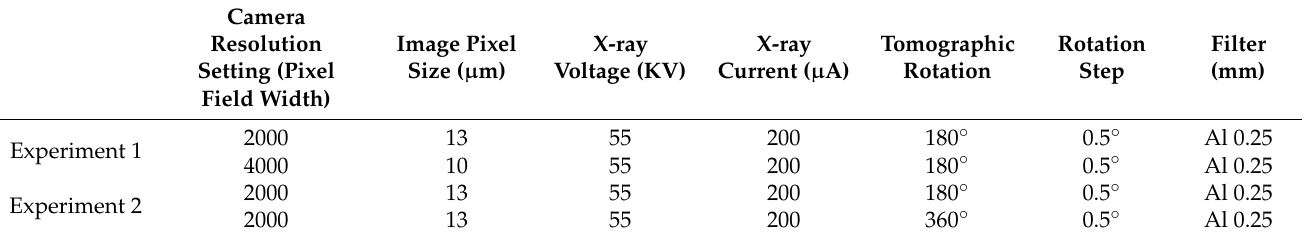
Table 3. Optimization of experimental scanning parameters.